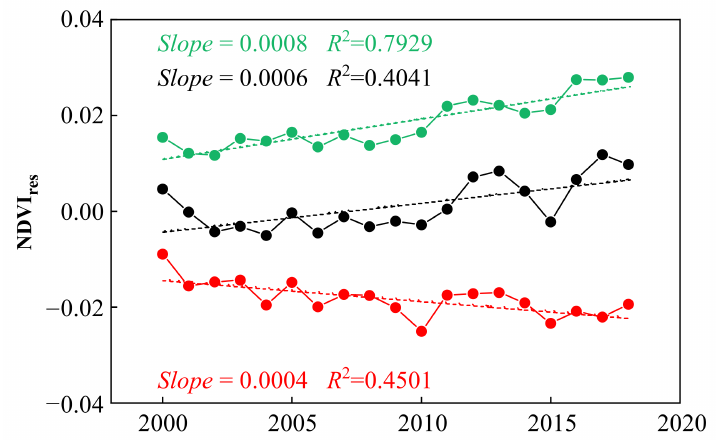
Figure 6. The interannual changes of NDVI res from 2000 to 2018. The black line: the average value of NDVI res ; the green line: the positive value of NDVI res ; the red line: the negative value of NDVI res .